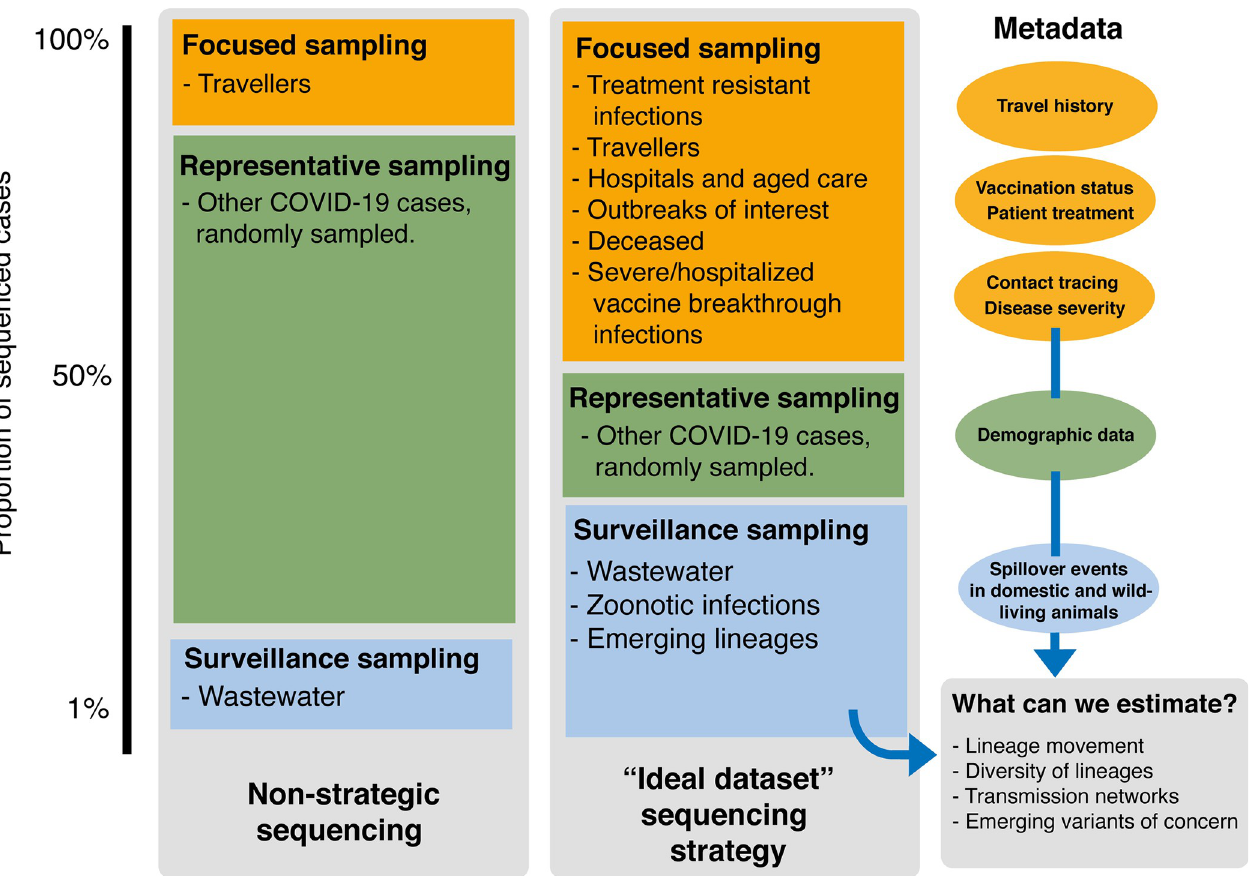
Fig 3. Illustration of the current “non-strategic” sequencing used for monitoring the COVID-19 pandemic, in comparison to the plan we have outlined as our “ideal dataset”. The two main streams of sequencing we have described, focused and representative sampling, are represented by the orange and green boxes, respectively. These streams are shown along with surveillance sampling, represented by the blue box. The size of each box represents the proportion of sequenced genomes being generated from each stream. The associated metadata with each stream is represented by a coloured bubble in the right panel. Following the blue arrows, we overview the parameters we can estimate from the “ideal dataset” sequencing strategy, combined with metadata.